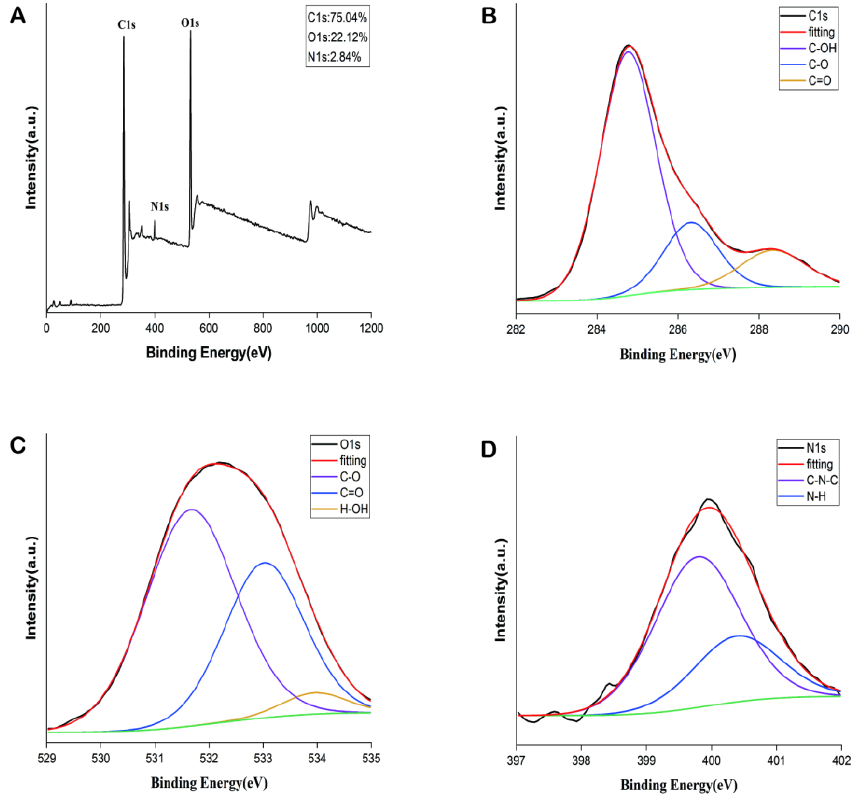
Figure 2. X-ray photoelectron spectroscopy (XPS) spectrum of PGC-CDs. ( A ) Survey spectra. ( B ) C1s. Figure 2. X - ray photoelectron spectroscopy (XPS) spectrum of PGC - CDs. ( A ) Survey spectra. ( B ) ( C ) O1s. ( D ) N1s. C1s. ( C ) O1s. ( D ) N1s.